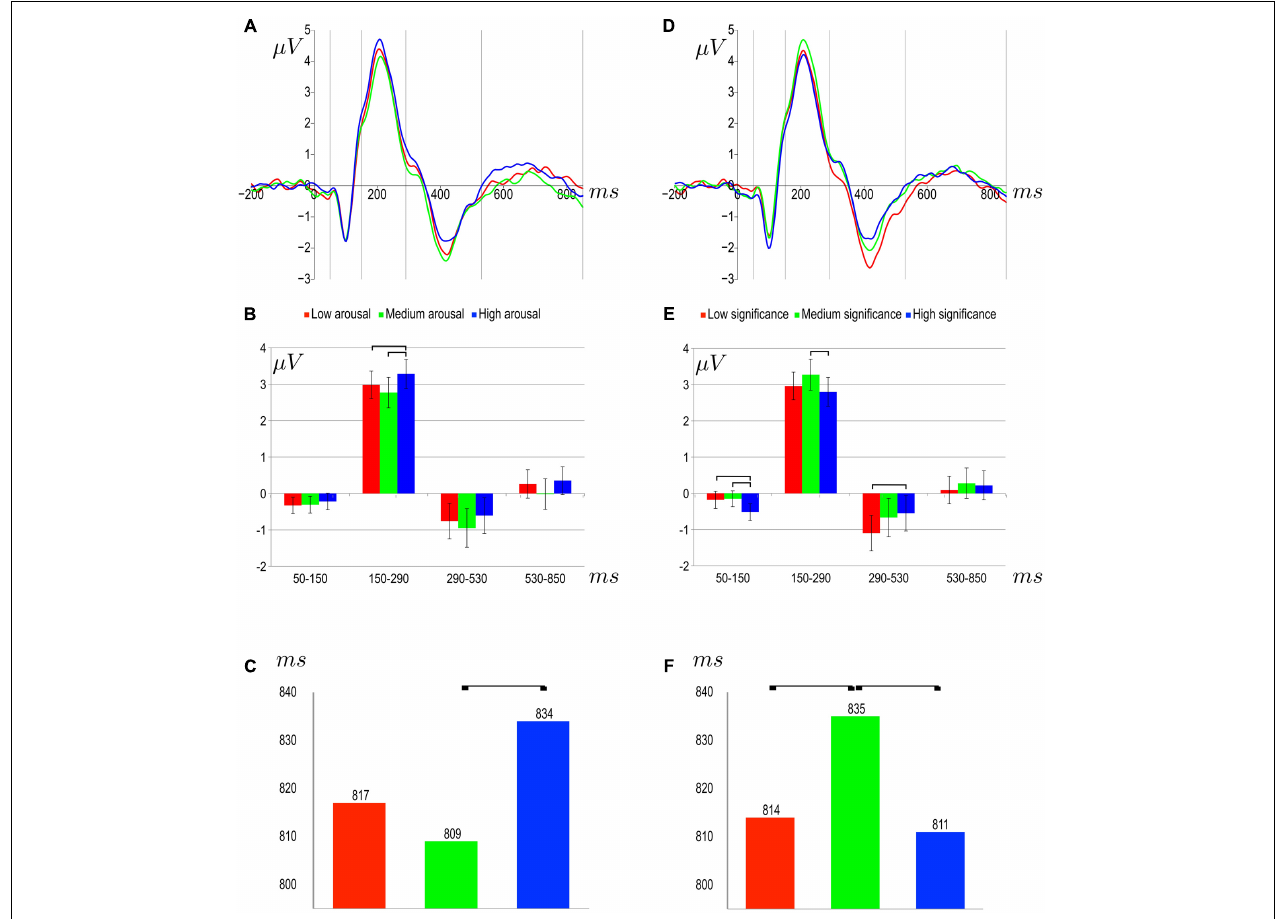
FIGURE 4 | Event-related potential (ERP) results. Top: grand average (across subjects and regions of interest ROIs)] amplitude of ERPs: (A) for different levels of arousing properties; (D) for different levels of subjective significance. Level is indicated by color according to the legend. The vertical lines mark time window boundaries. Horizontal axis – time in ms; vertical axis - amplitude in µ V. Middle: average amplitudes of components (with standard error indicated) in consecutive time windows for: (B) different levels of arousing properties; (E) different levels of subjective significance. Significant differences are indicated with square brackets. Amplitude in µ V is represented on the vertical axis. Bottom: average response time in ms (C) different levels of arousing properties; (F) different levels of subjective significance.